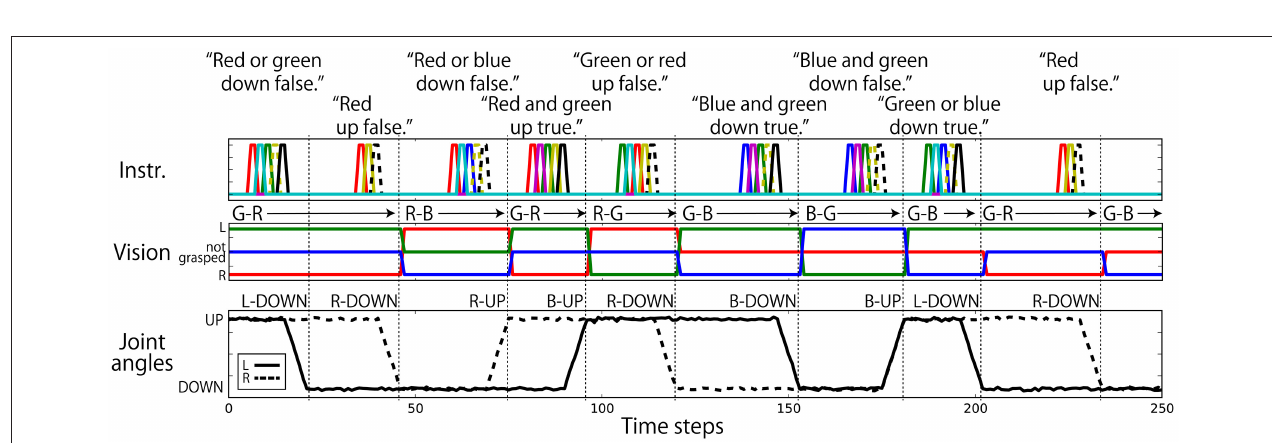
FIGURE 2 | Overview of the flag task. The experimenter makes the robot grasp two colored flags. Instructions are given as sentences in the form of an objective (“red,” “green,” “blue”), a verb [“up” (i.e., lift), “down” (i.e., lower)] and a truth value (“true,” “false”). The robot must generate one of six goal-oriented actions (L-UP, L-DOWN, R-UP, R-DOWN, B-UP, B-DOWN) in accordance with the instruction. In the objective parts, two color words can be concatenated by “and”. In this case, the robot must generate B-UP (B-DOWN) action. Two color words also can be concatenated by “or,” in which case the robot must move either arm. The actual movements corresponding to these goal-oriented actions for each starting posture are indicated by the arrows in this figure.